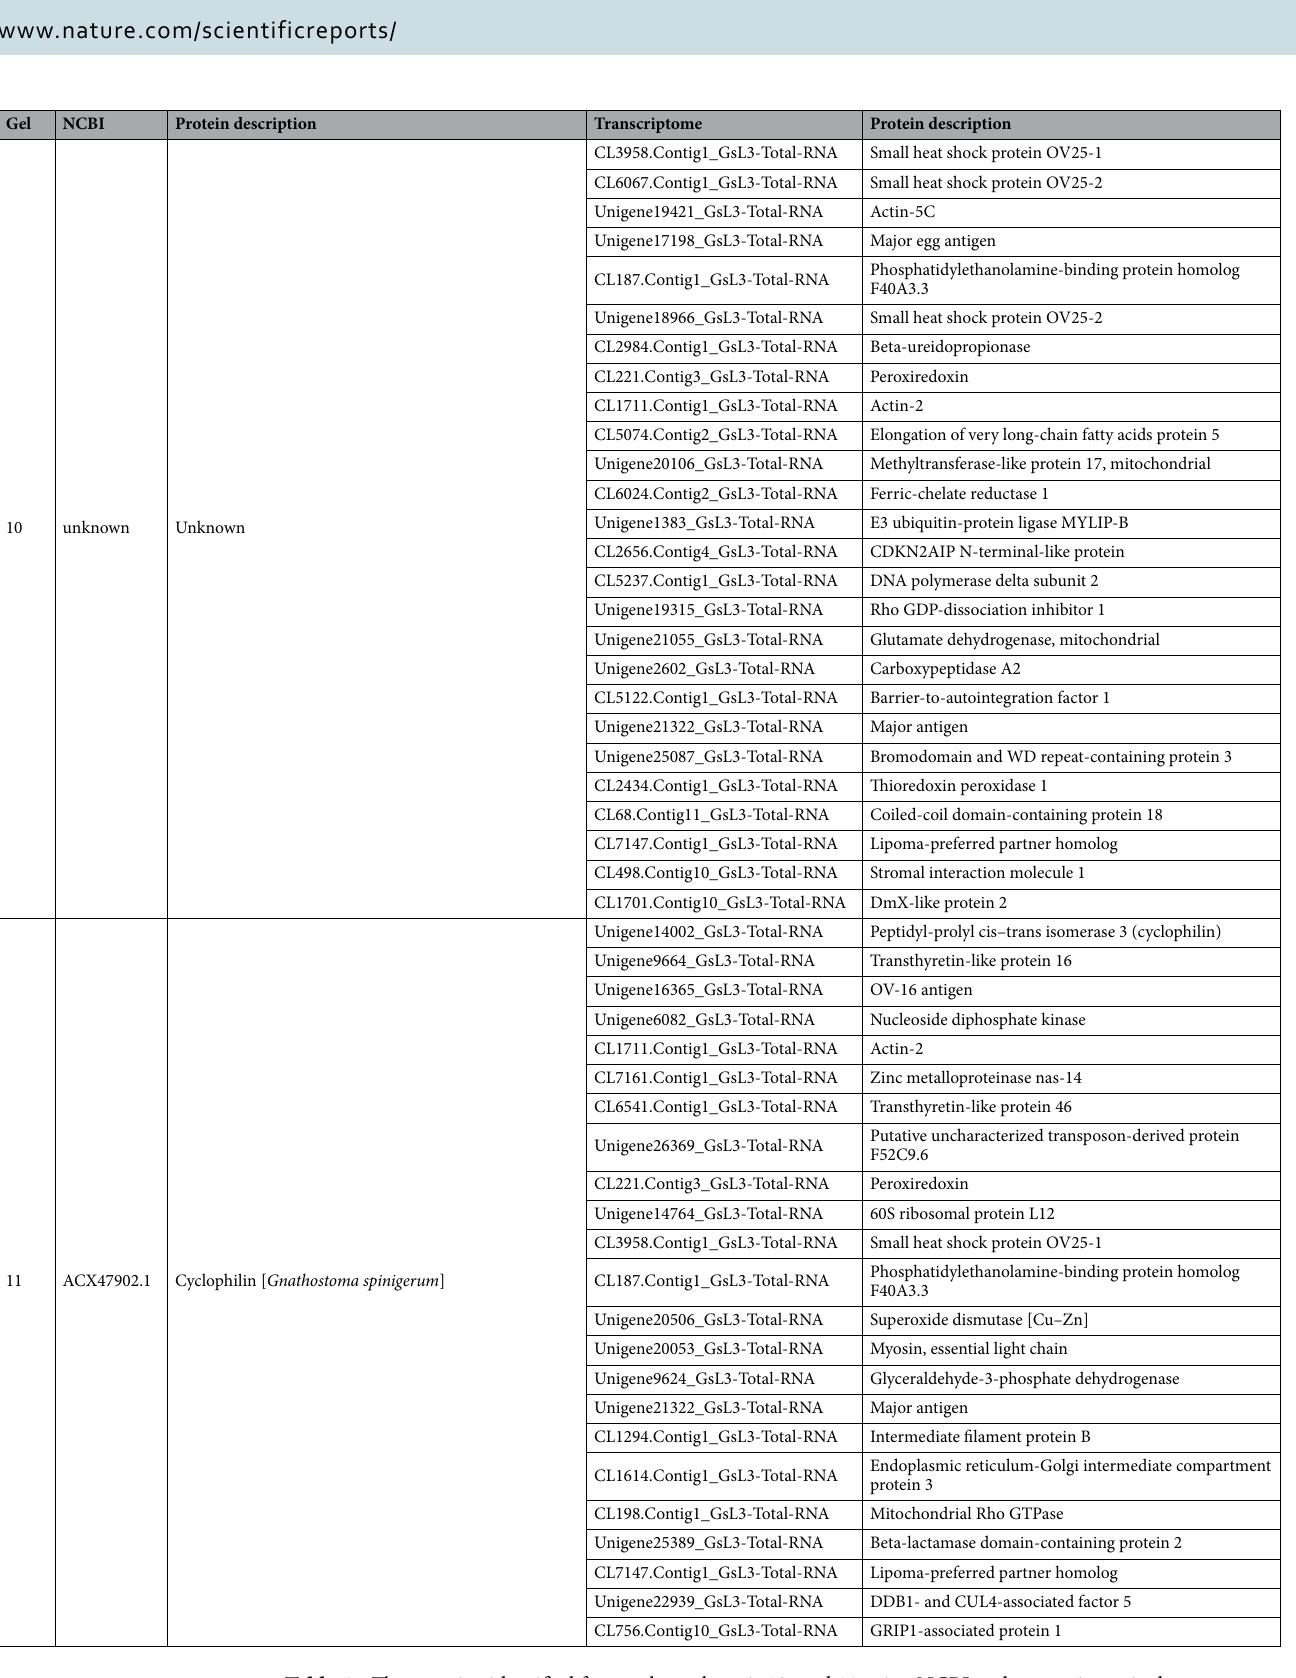
Table 4. The proteins identified from gel numbers 9, 10, and 11 using NCBI and transcriptomic